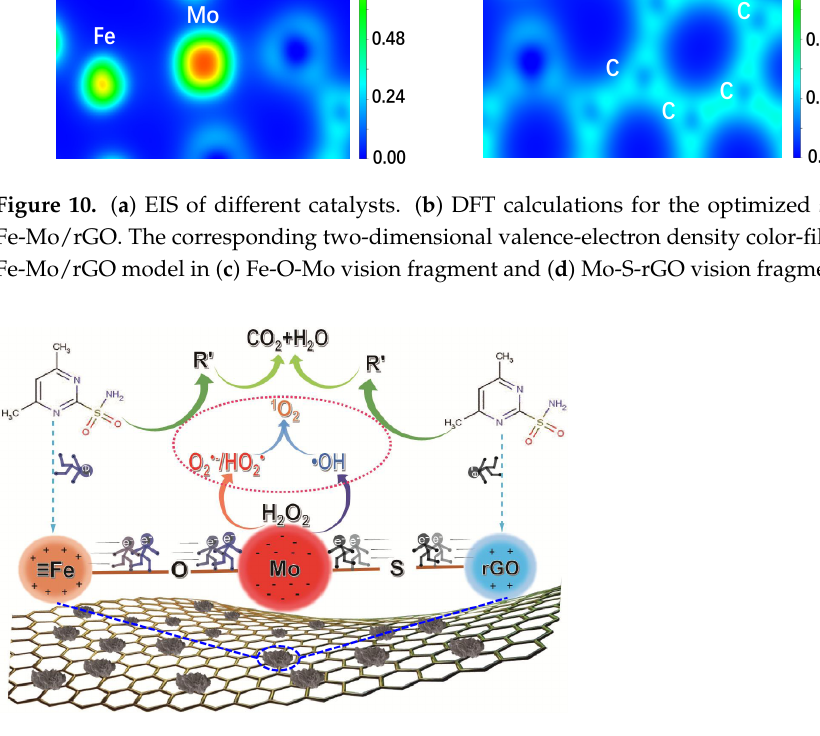
Figure 11. SMT degradation mechanism in the Fenton-like reaction over the Fe-Mo/rGO catalyst.